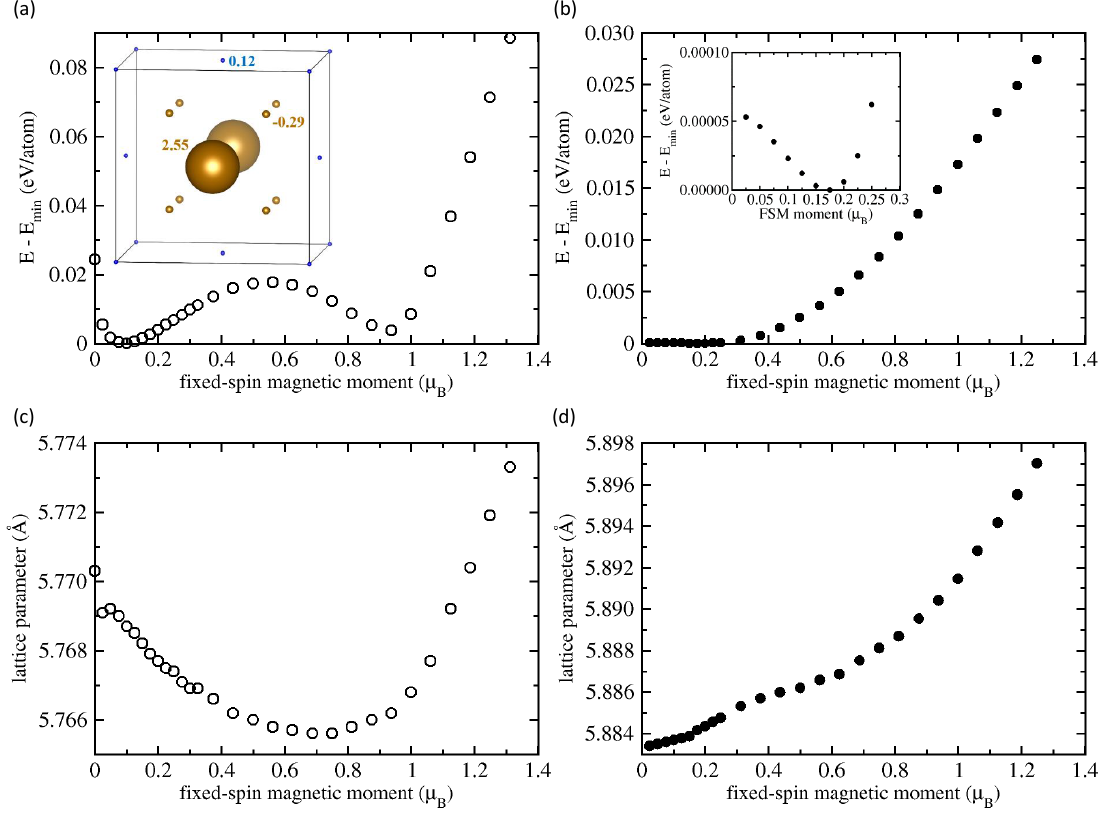
Figure 4. Computed total energies for non-stoichiometric Fe 2 AlTi. The results for the excess Fe concentration Fe 56.25 Al 25 Ti 18.75 are shown in ( a , c ). For excess Ti, the corresponding results are displayed in ( b , d ). The values of the FSM are per four atoms in order to allow for a comparison with the figures visualizing results for the stoichiometric Fe 2 AlTi discussed above. The inset within part ( a ) shows the local magnetic moments of atoms in the state with the lowest energy (some atoms are shown with their periodic images) and that in part ( b ) magnifies an extremely shallow energy